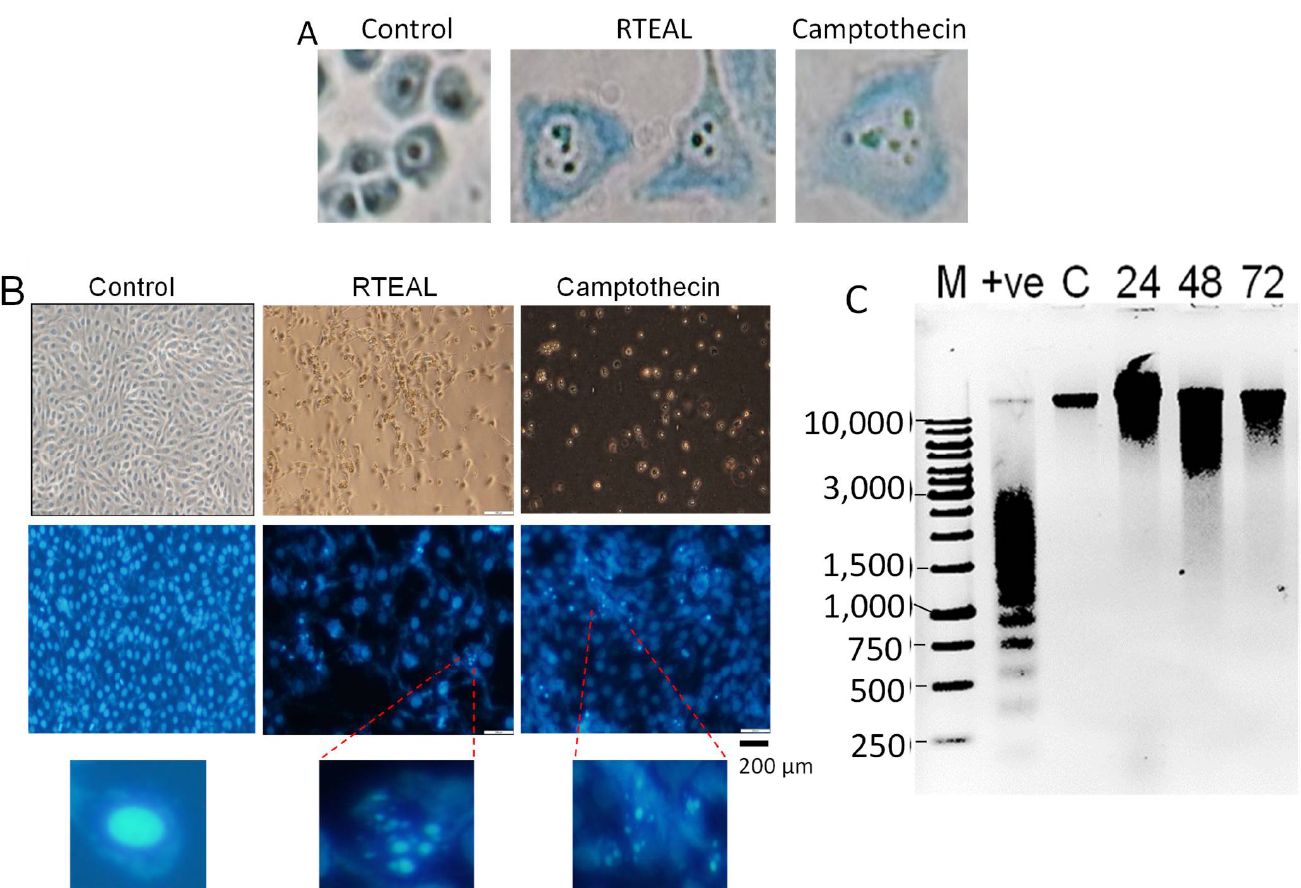
Figure 2. Effects of RTEAL on cell morphology and DNA fragmentation. MCF-7 cells were treated with 28 µg/mL and stained with methylene blue ( A ) and DAPI ( B ). Morphological changes were observed under a microscope with 400× and 100× magnification for ( A , B ), respectively. Intense DAPI-stained cells with condensed and fragmented nucleus were enlarged. ( C ) Agarose gel electro- phoresis of extracted DNA. Lane M: 1 kB DNA marker; lane +ve: camptothecin treated cells pro- vided by the kit and lane C: control treated with DMSO. Lanes 24, 48 and 72: samples treated for 24, 48 and 72 h,